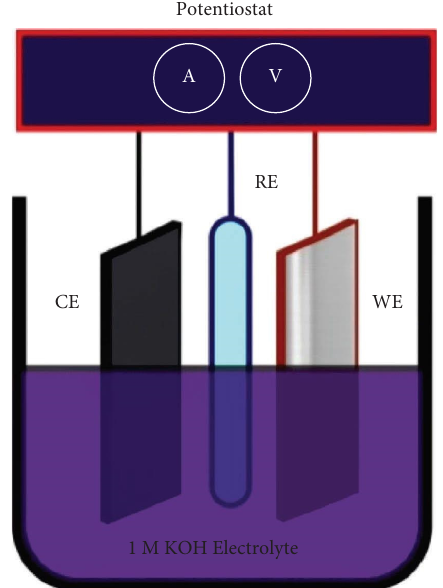
Figure 3: Schematic of the working electrode (WE), reference electrode (RE), and counter electrode (CE) in a three-electrode system connected to a potentiostat